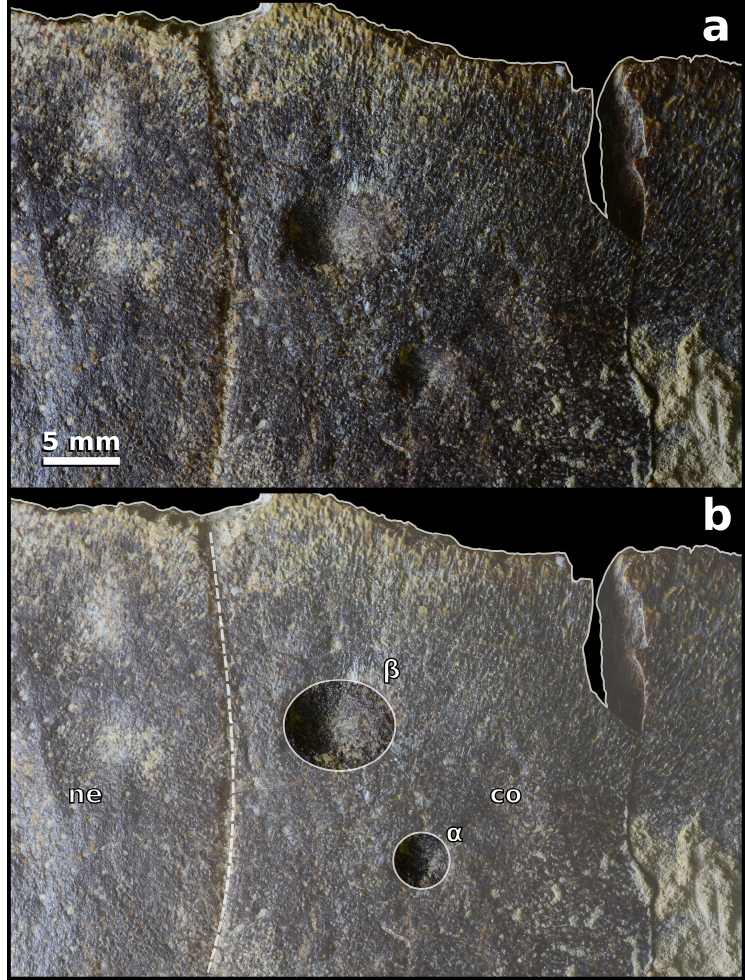
Figure 3. Detail of two Karethraichnus borings ( α and β ) occurring on the exterior of the fragmentary turtle carapace MUSM 4716; ( a ) photograph and ( b ) explanatory line drawing. Abbreviations: co, costal plate; ne, neural plate. The dashed line in panel ( b ) indicates the position of the co–ne suture. Scars α and β may be misidentified as tooth marks left by the apices of roughly